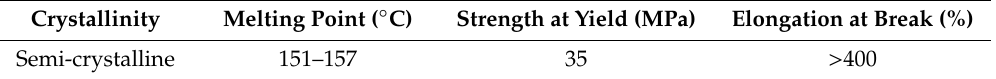
Figure 2. XRD curve of PVDF particles. Table 1. Physical and chemical properties of